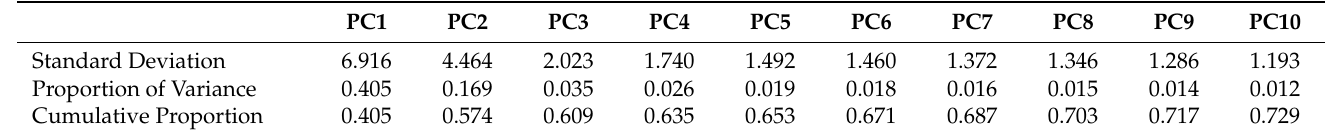
Table 2. Summary of the importance of PCA by principal components (PC) for PTPM. Source: